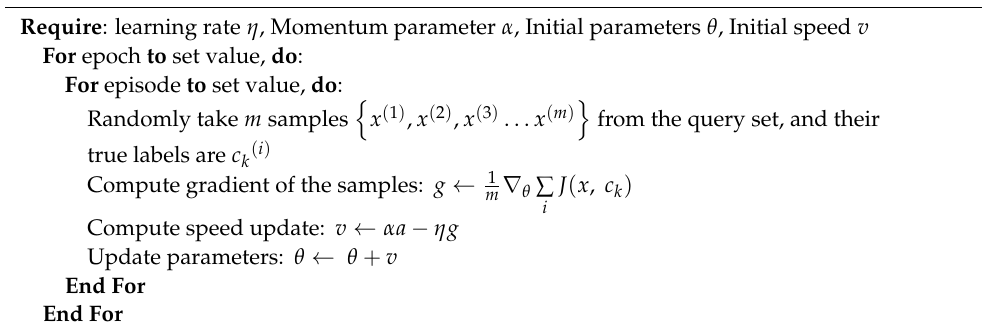
Algorithm 1 Update the trainable parameter θ of WPNF via the stochastic gradient descent method of